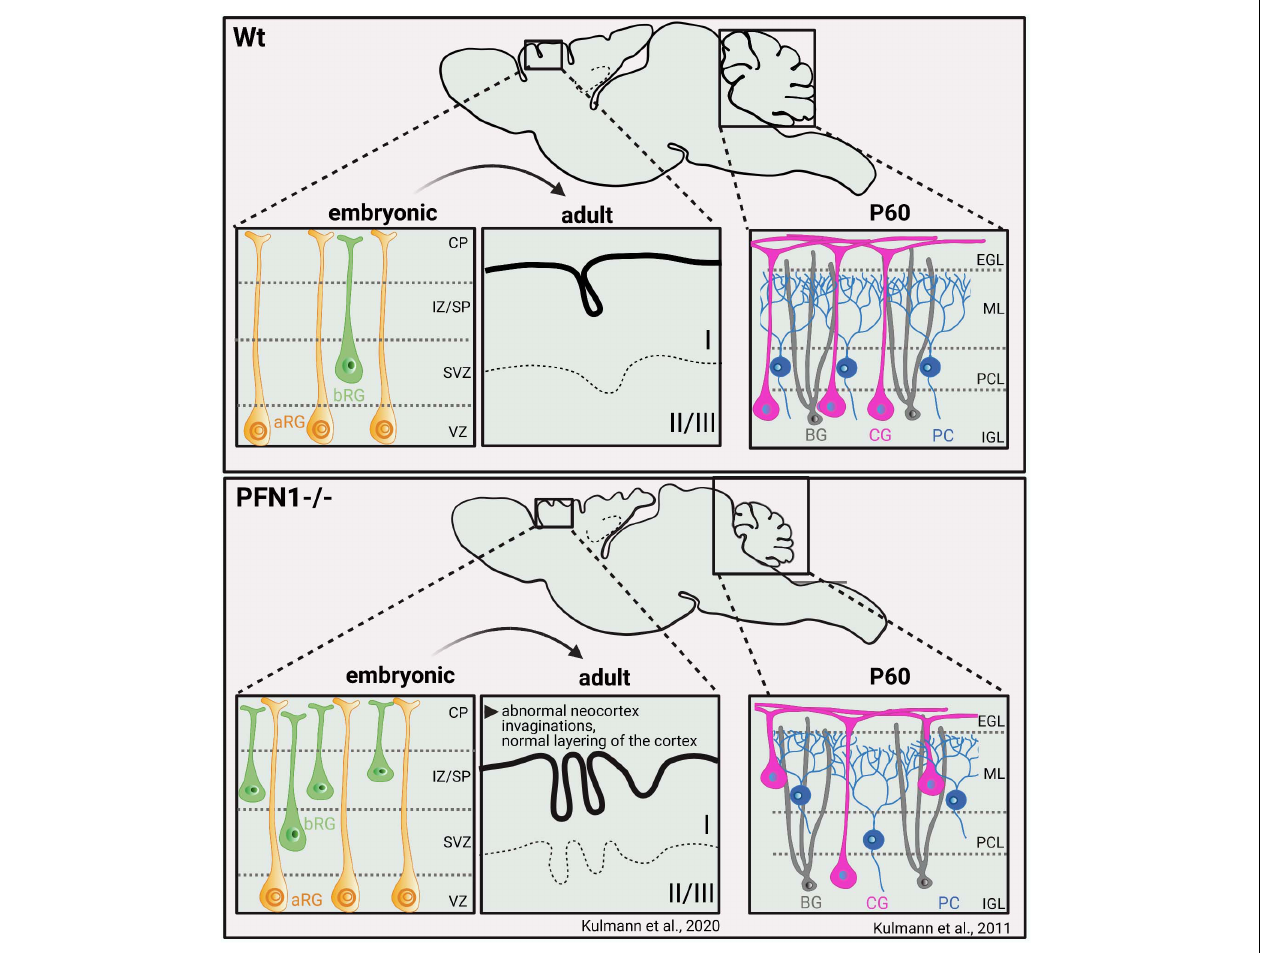
FIGURE 4 | PFN1 loss perturbs brain development and causes malformations of cortex and cerebellum through altered cellular compositions. Pfn1 − / − mice exhibit smaller brains, with size reductions, particularly of the cortex (–25%) and cerebellum (–50%). Defects in cortical development are caused prenatally by a distinct subset of neural progenitor cells, known as basal radial glia. PFN1 loss affects the orientation of basal radial glia cell divisions during development, causing transiently ectopic neurogenesis. Adult mice show abnormal invaginations of the neocortex while cortical layering is principally preserved (Kullmann et al., 2020). Cerebellar hypoplasia develops postnatally by migration defects of cerebellar granule cells and Purkinje cells (Kullmann et al., 2011, 2012, 2015). Impaired adhesion and migration of cerebellar granule cells along the processes of Bergmann glia are causative for this phenotype. bRG, basal radial glia; aRG, apical radial Glia; CP, cortical plate; IZ/SP, intermediate zone/subplate; SVZ, subventiruclar zone; VZ, ventricular zone; BG- Bergmann Glia; CG- cerebellar granule cells; PC- purkinje cells; EGL, external granular layer; ML, Molecular layer; PCL, Purkinje cell layer; ICL, Internal granular layer; P60, postnatal day